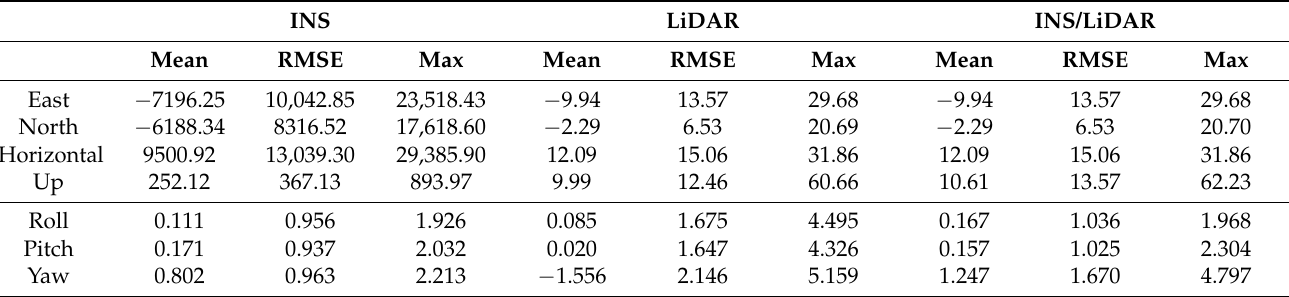
Table 3. D-28—position (m) and attitude (deg) error